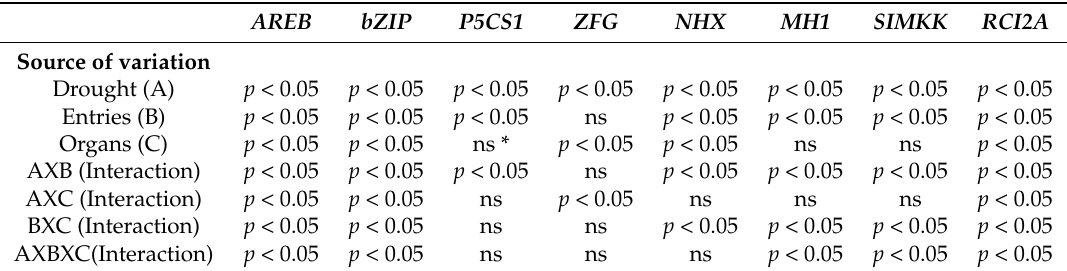
Table 4. The effect of drought stress, species, and tissue on genes expression (mean ± SE)